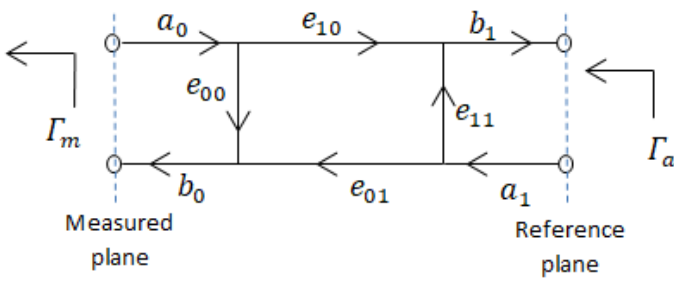
Figure 3. Quadrupole representation of microwave set-up